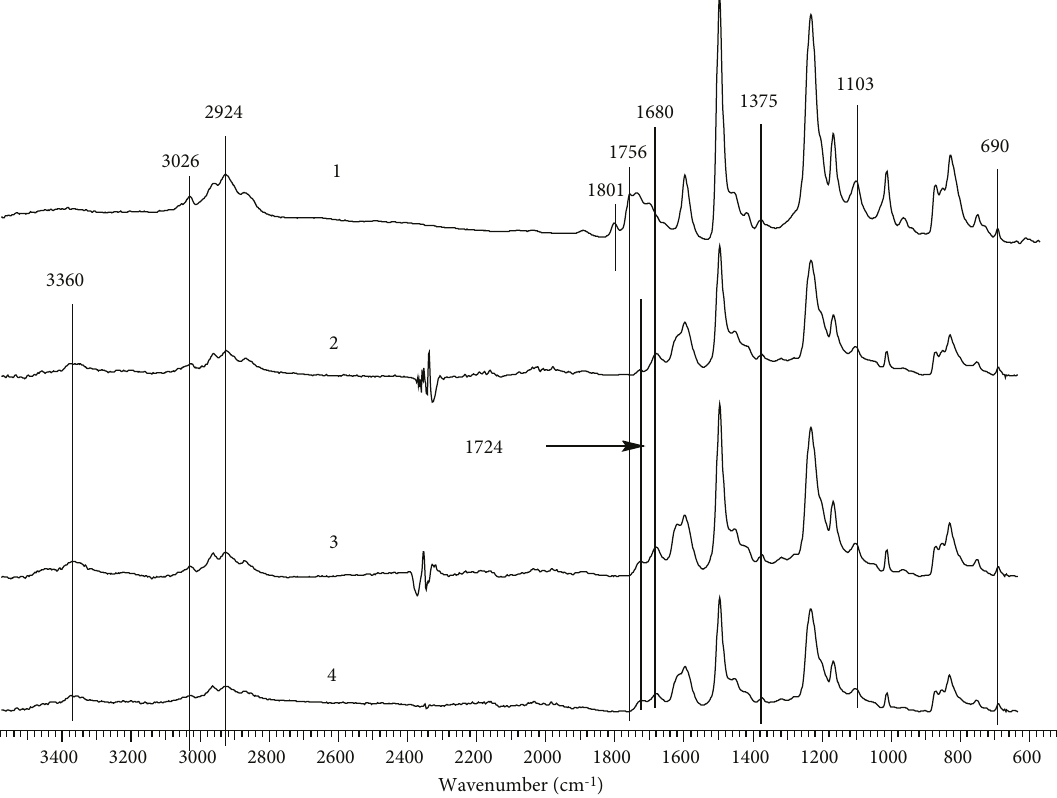
Figure 2: FTIR spectra of the cured neat ROL-II resin (1) and the cured RII-1,3-PDA (II-IV) blends prepared by heating in the thermal regime up to T ( ° С ): 260 (4), 320 (3), and 350 fin cur